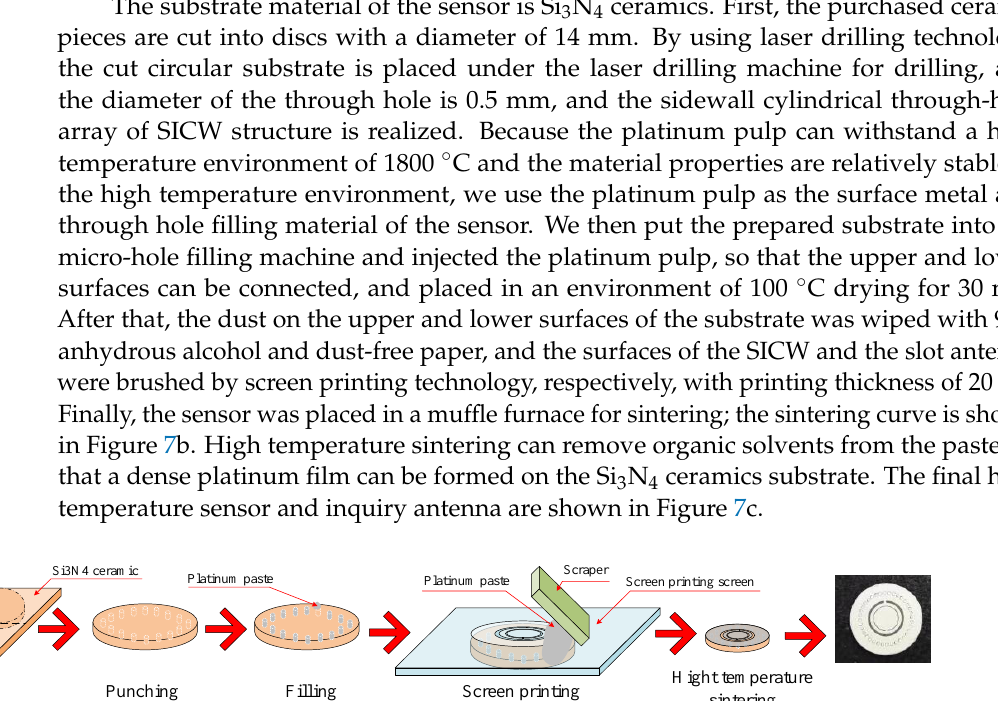
Figure 6. ( a ) Resonant frequency of the sensor, ( b ) electric field of the sensor, ( c ) magnetic field distribution of the sensor.